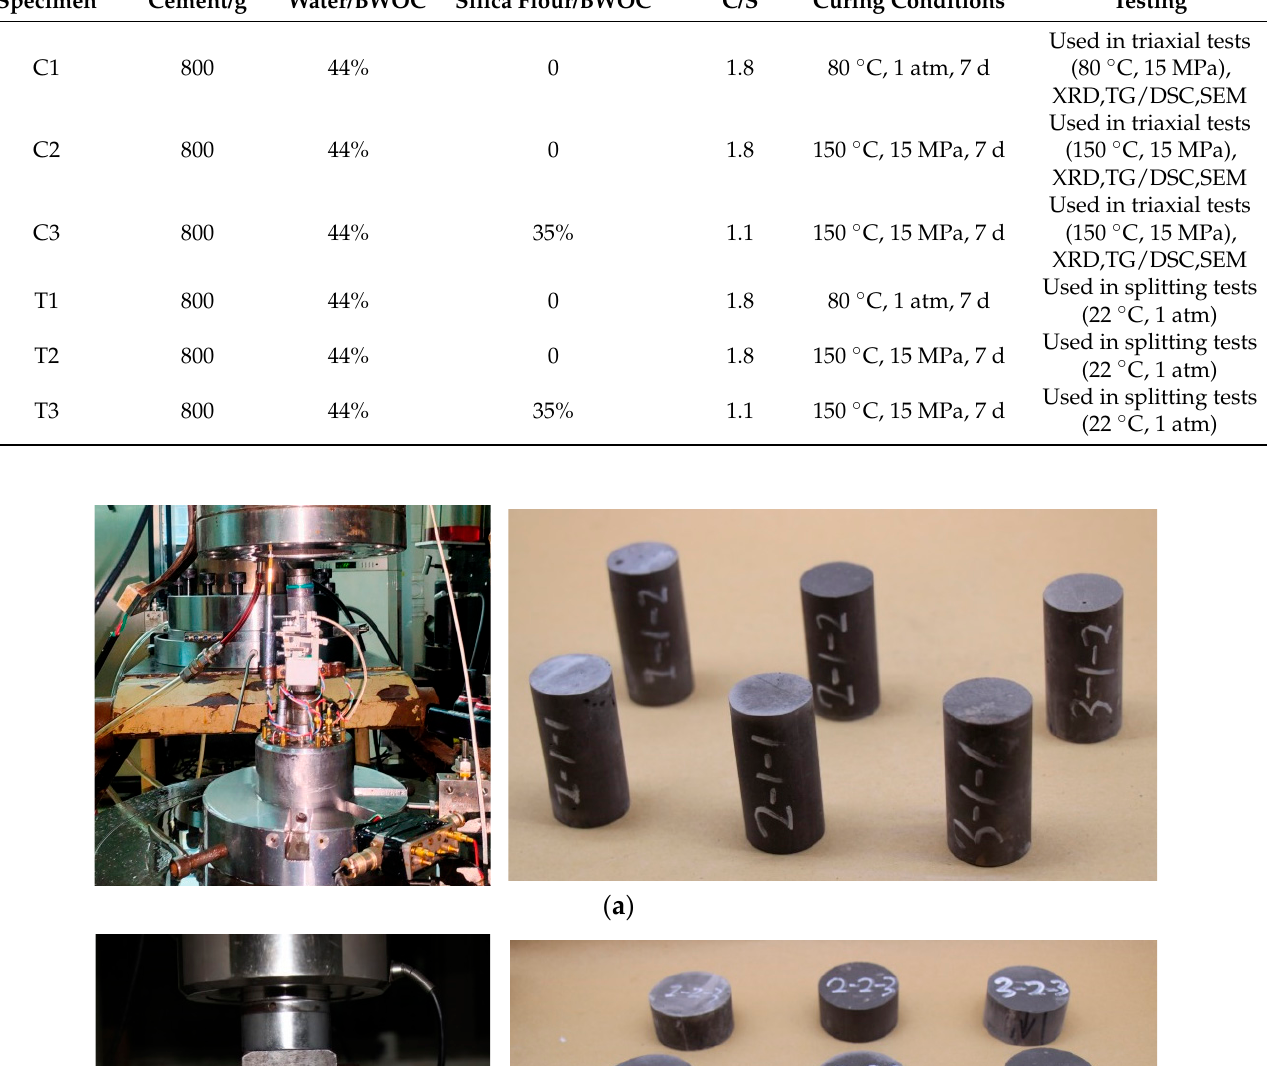
( b ) Figure 2. Atomic structures of C-S-H with C/S = 1.1 before ( a ) and after ( b ) reactions at 1500 K. Note: Yellow for silica atoms; red for oxygen atoms; blue for calcium atoms. These particles are equilibrated at T = 300 K (27 °C) using MD simulations in the canonical (NVT) ensemble, then relaxed at T = 300 K and P = 15 MPa in the NPT ensem- ble. Since the energy barrier associated with the breakage of Si-O-H and the formation of Si-O-Si is high, following Refs. [19,24], the polymerization simulations are carried out at an elevated temperature in the NVT ensemble to accelerate the reaction, thus reducing